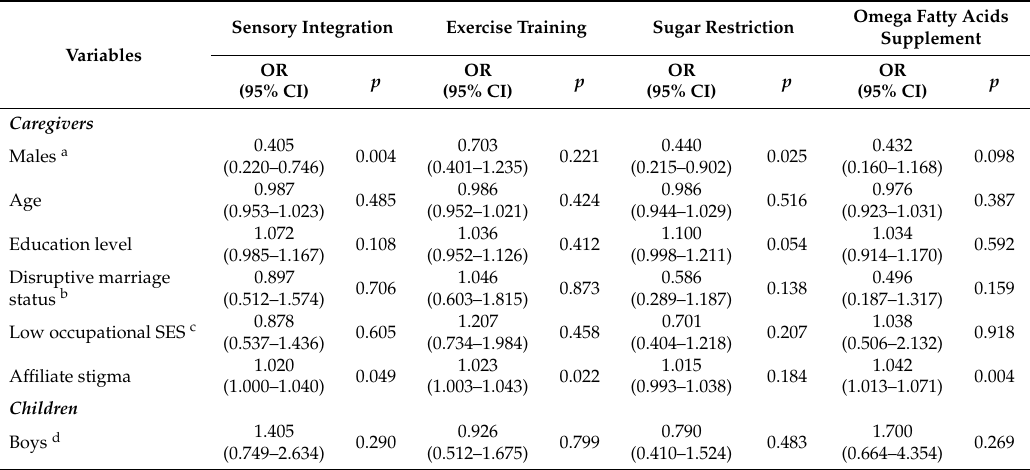
Table 3. Factors related to the employment of complementary and alternative intervention strategies (CAIS) for